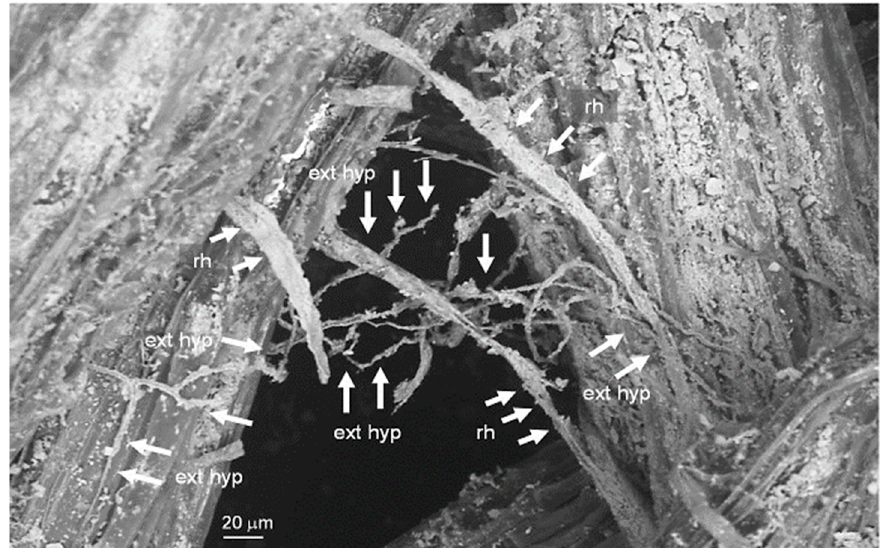
Figure 4. SEM image of extra-radical hyphae forming a shared mycorrhizal mycelium on fine lateral roots of Cucumis melo L., grown on flattened spelt. ext-hyp: AMF extra-radical hyphae; rh: root hairs. Magnification = 1.0 KX.